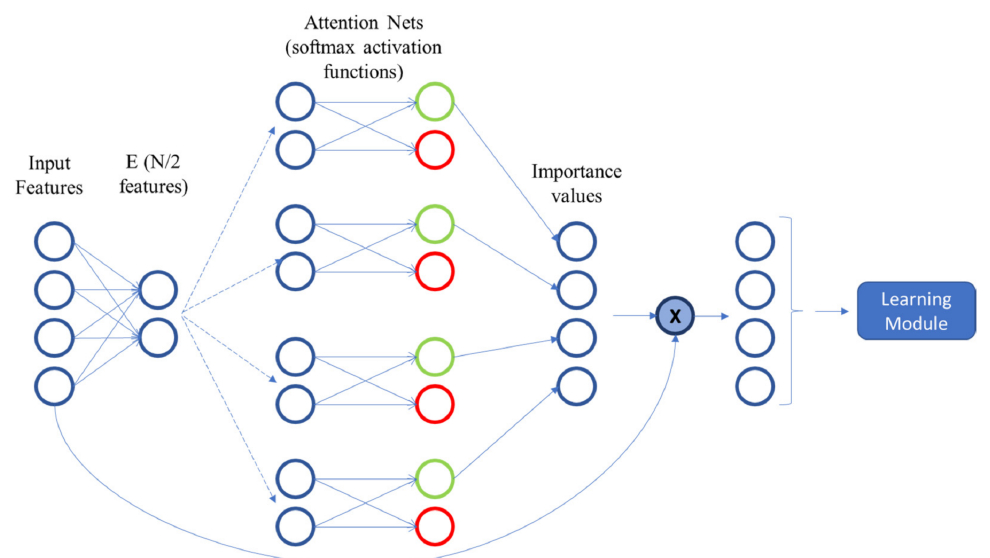
Figure 9. Example representation of the AFS network. Note that the E layer has N /2 neurons. In the AFS2 configuration, the E layer has N features. As described in the original work, the E layer has a tanh activation function. It serves as input to N attention nets, each of them used to determine the importance value of an input feature. Based on